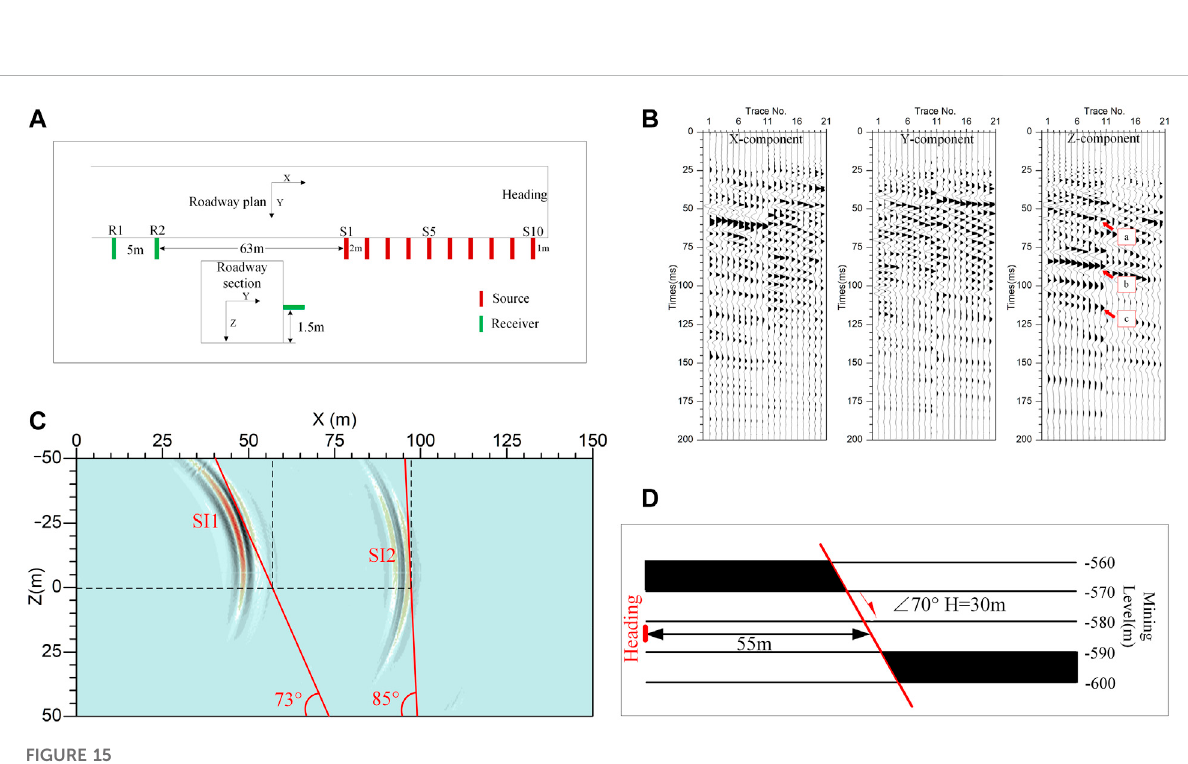
Frontiers in Earth